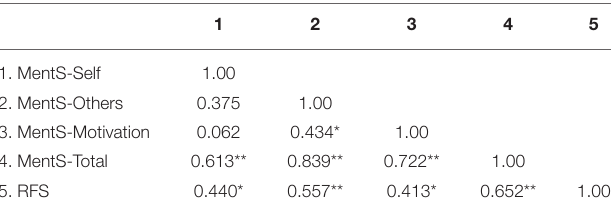
TABLE 3 | Pearson’s and partial correlations between RFS and MentS ( N = 26).